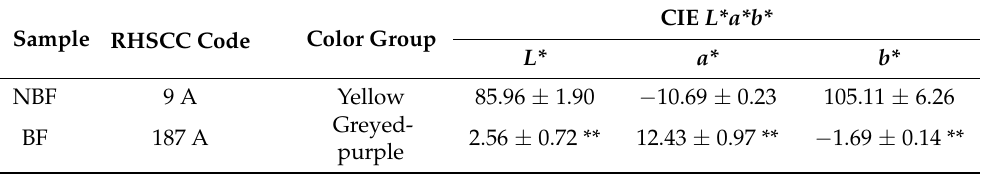
Table 1. The color parameters of NBF and